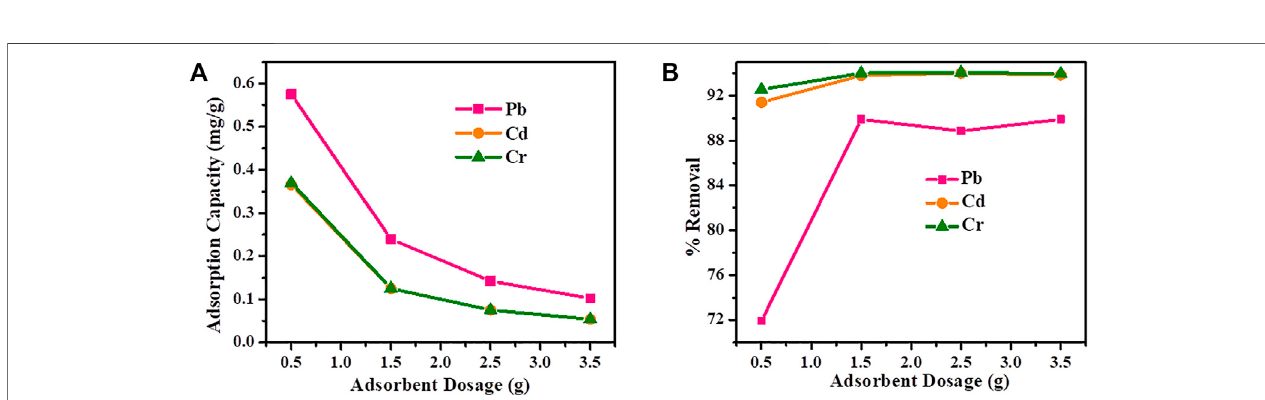
FIGURE 3 | Effect of adsorbent dose on (A) adsorption Capacity and (B) removal ef fi ciency of Cd. Pb and Cr.